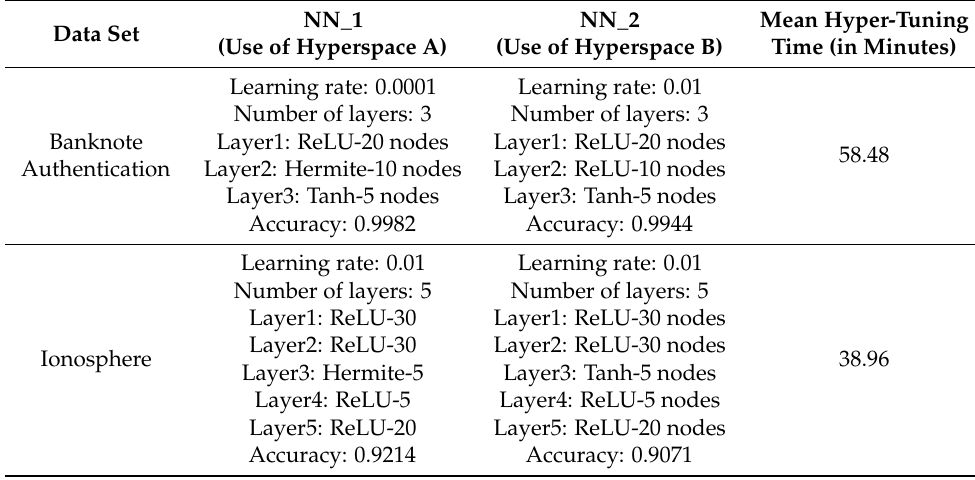
Table 9. (Second Experiment) Optimal hyperparameter values, classification accuracy evaluated on the testing data, and the mean time needed to perform the hyperparameter optimization (i.e., mean hyper-tuning time) obtained by the best neural network (NN_1) using the Hyperspace A, and the best neural network (NN_2) using the Hyperspace B (Data sets: Banknote Authentication, Ionosphere). Data